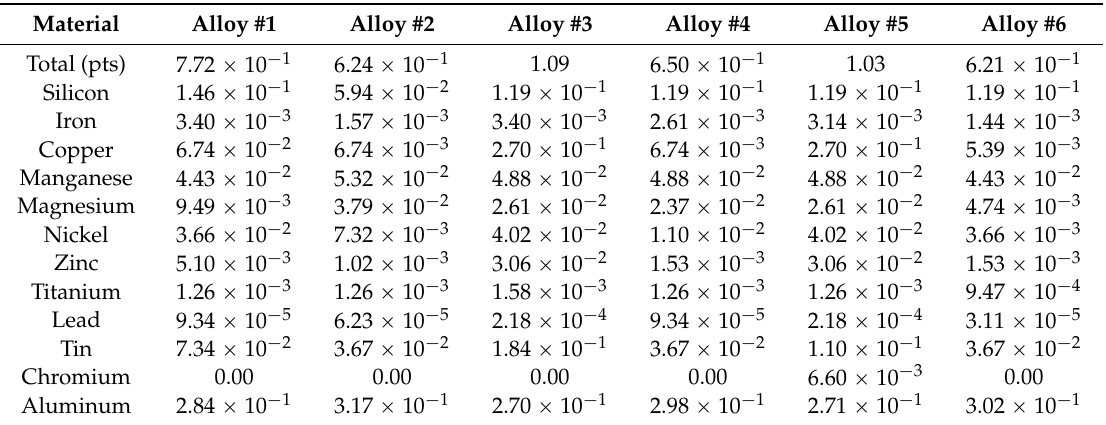
Table 8. Maximum environmental impact of 1 kg of the studied aluminum